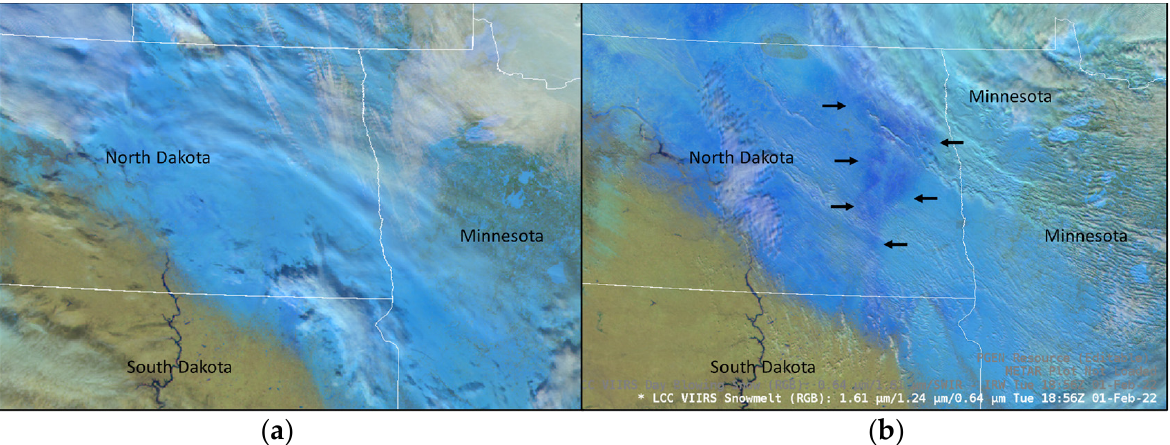
Figure 1. 29 January ( a ) and 1 February ( b ) 2022 VIIRS Snowmelt RGB over the northern US plains. See text for image interpretation.